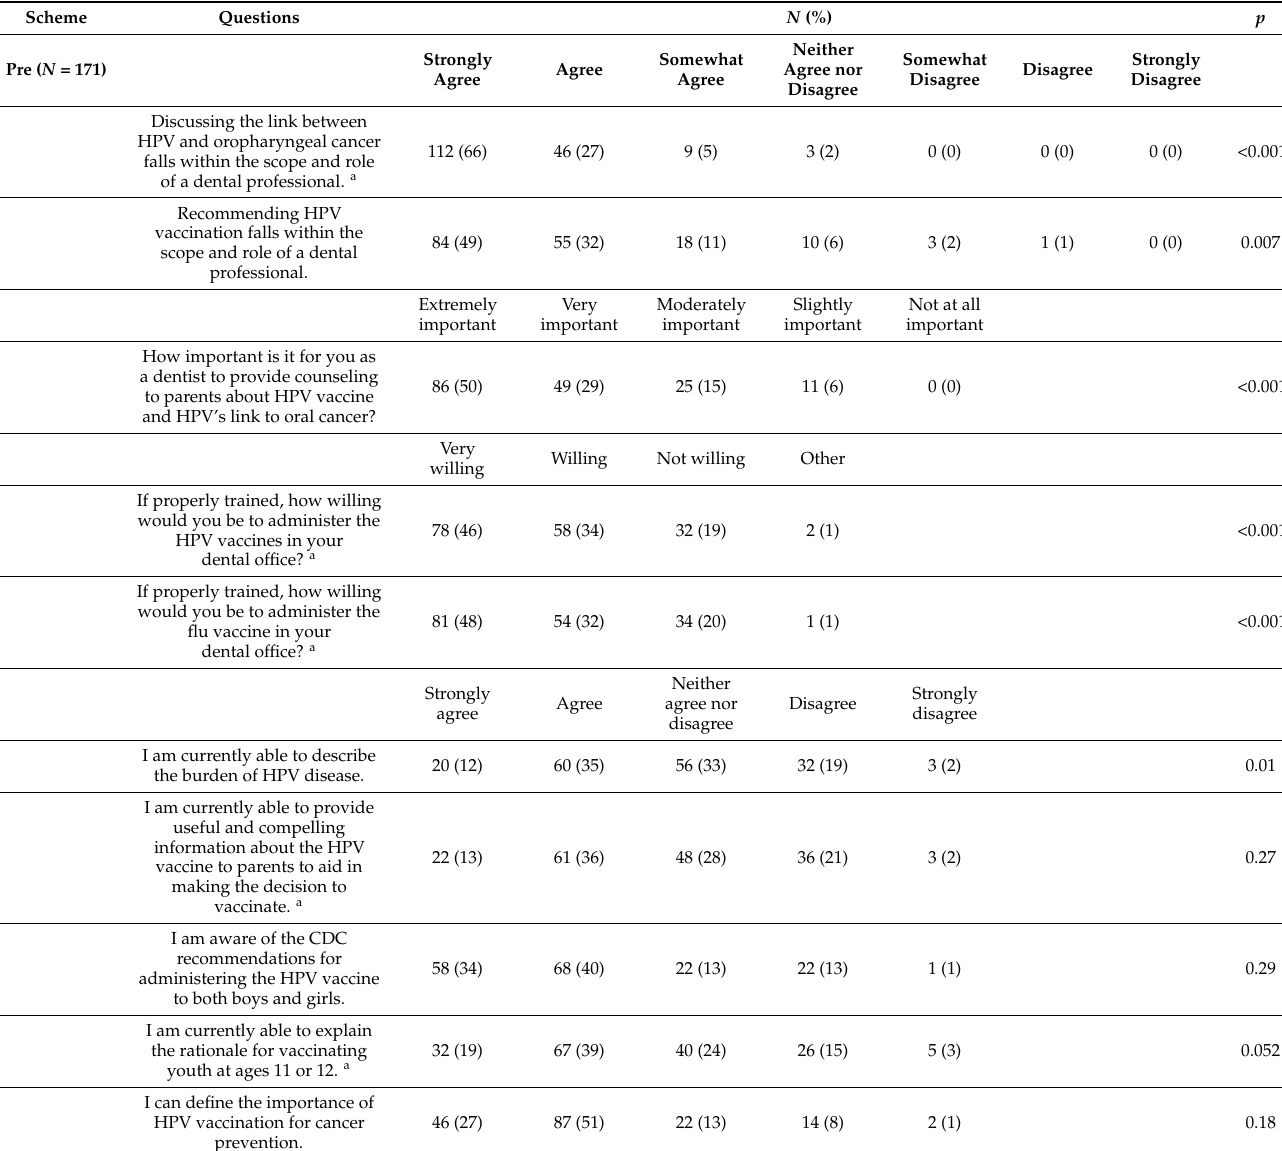
Table 3. Perceived Responsibility, Willingness, and Understanding of HPV and OPC (electronic pre-survey).